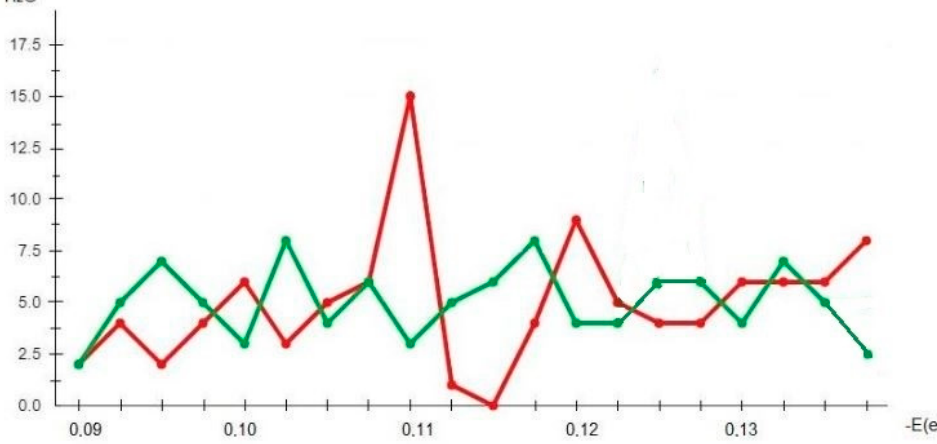
Figure 1. Distribution of the number of water ( Н 2 О ) molecules in EVOdrop water and tap water according to the energy of hydrogen bonds.